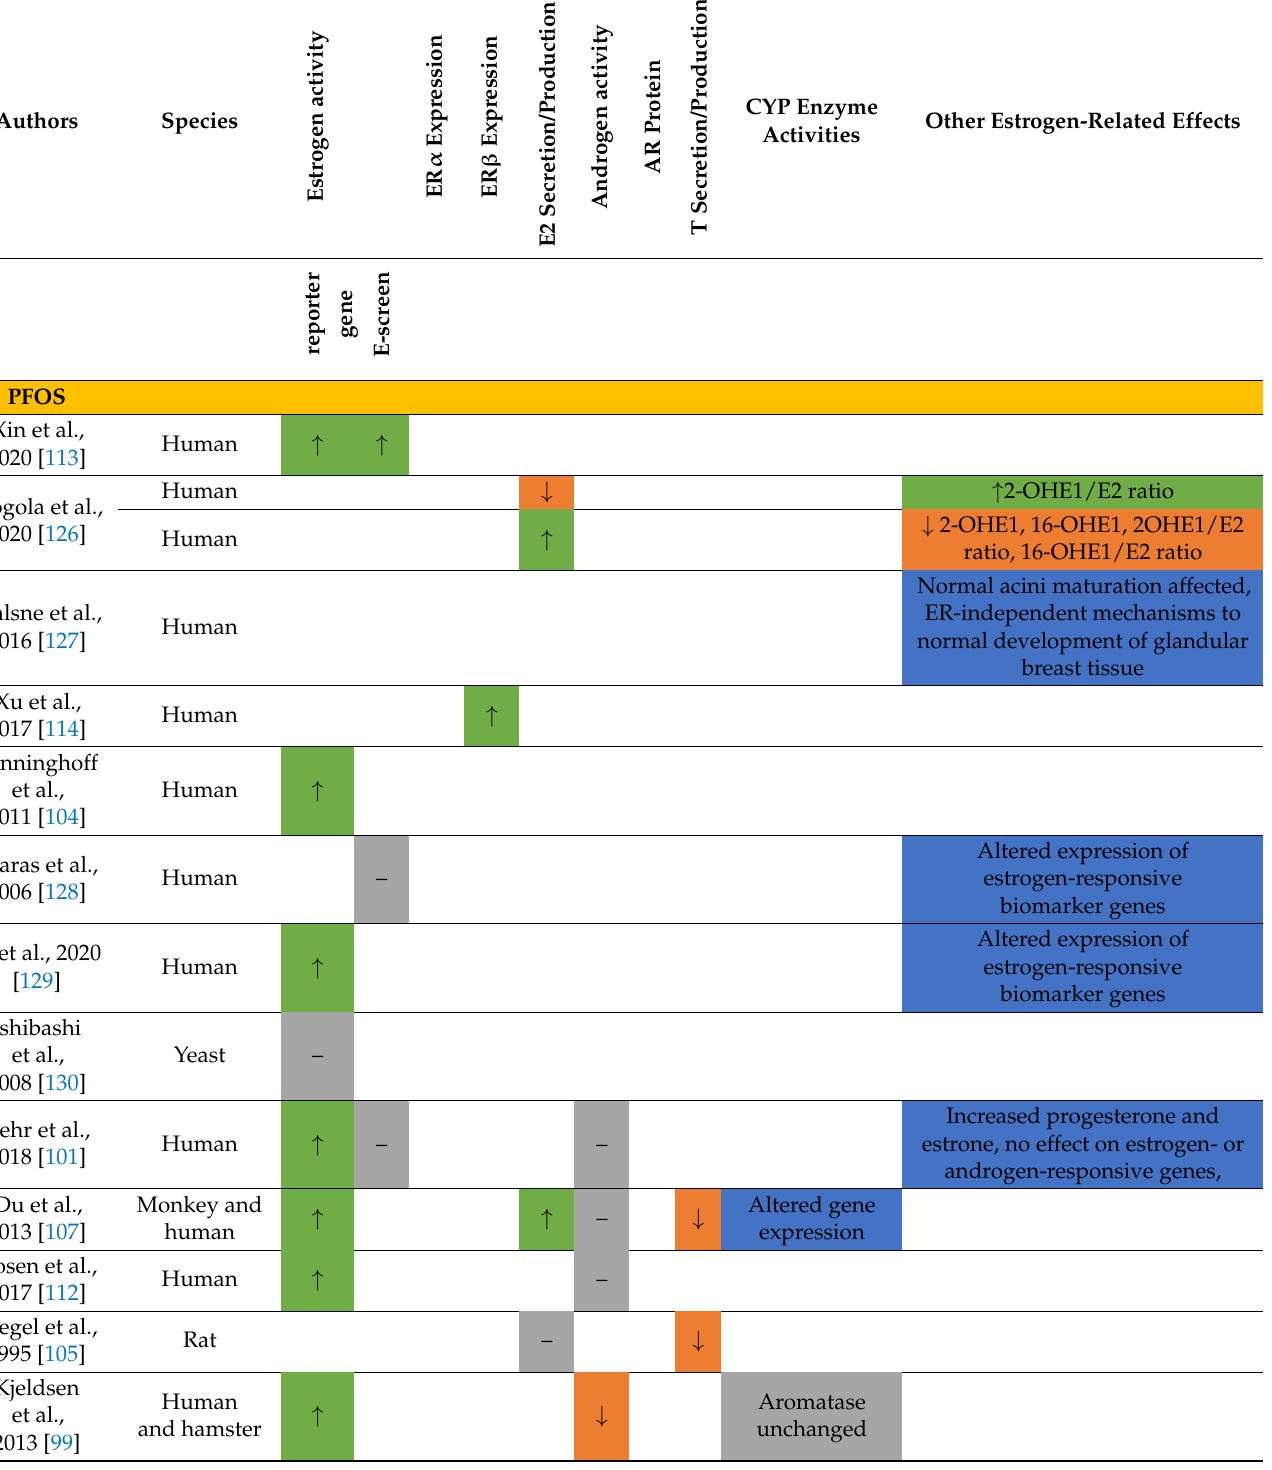
Table 9. In vitro results related to PFAS exposures and estrogen and androgen pathways PFAS- associated thyroid hormone